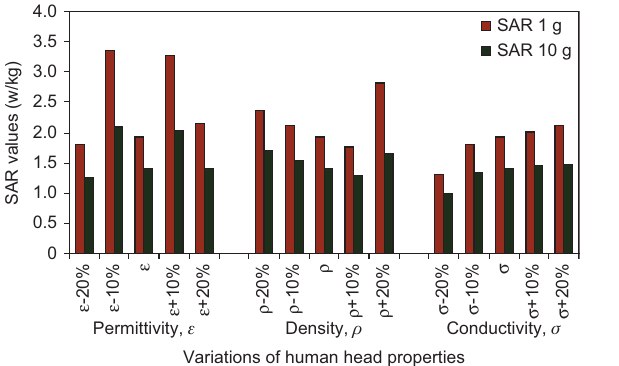
Figure 4 SAR values in human head at 900 MHz with antenna sub- strate of Rogers RO3006 (loss free).